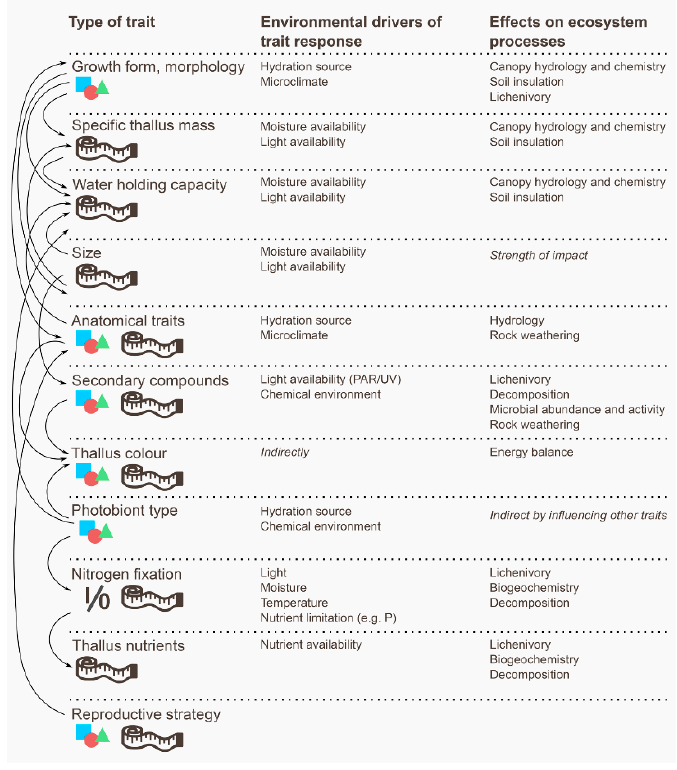
Figure 1. Schematic to show contrasting types of traits that might yield qualitative (shapes) or quantitative (measuring tape) data, and their potential relationship to environmental drivers controlling a species/community response, and/or the effect on ecosystem processes. Arrows show an a priori understanding of linkages between traits (e.g., photobiont type also affects water holding capacity). Note that thallus colour is indirectly related to the environment through associated traits such as photobiont type or secondary compounds. Additionally, that reproductive strategy associates with lichen anatomical traits but is separated out because of its link through to demographic processes that also affect community composition.